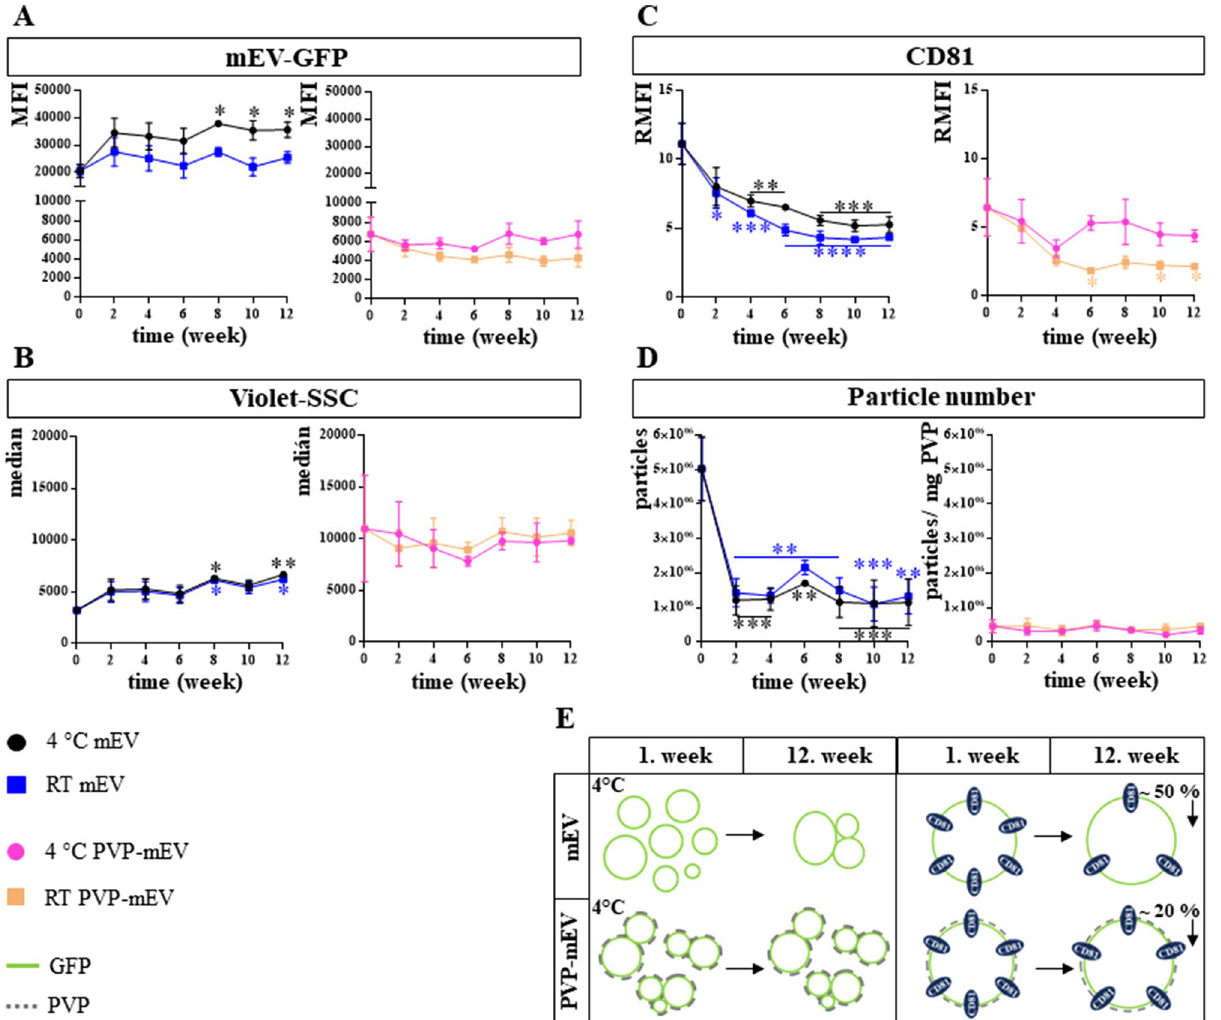
Figure 4. Stability investigation of free mEV and mEV-loaded PVP fibers (PVP-mEVs) by flow cytometry. The stability of free mEVs and PVP-mEVs kept at 4 °C or RT was monitored for 12 weeks, every two weeks by flow cytometry. The stability was investigated based on the membrane-bound GFP signal of mEVs ( A ), the Violet- SSC parameter correlating with the vesicle size ( B ), CD81 expression ( C ) and particle number ( D ). Schematic illustrations of the hypothesized mechanism of the changes observed for free mEV and PVP-mEV samples kept at 4 °C are summarized in panel ( E) . n mEV-GFP = 3, n Violet-SSC = 3, n CD81 = 3, n particle number = 2 (Figure was prepared using GraphPad Prism 7.00 for Windows, GraphPad Software, San Diego, California USA, http:// www. graph pad.